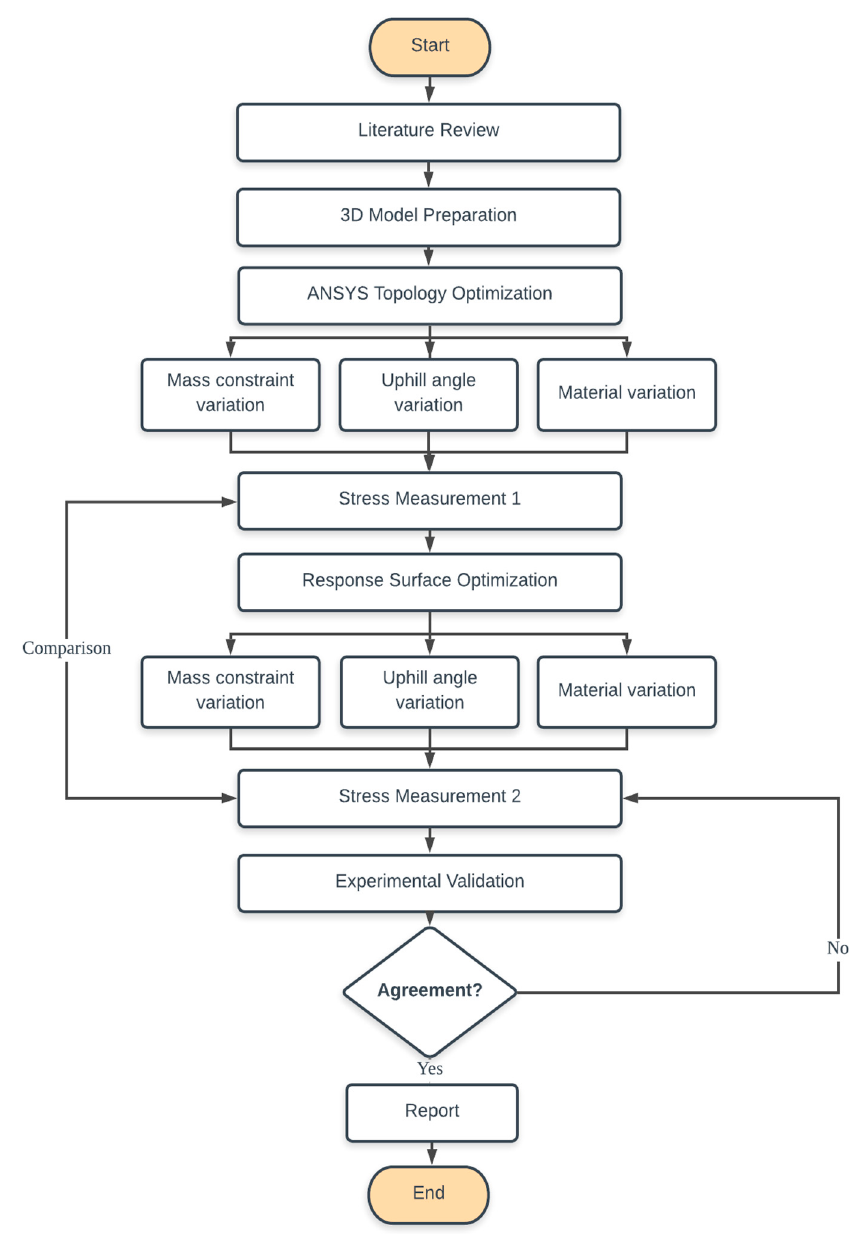
Figure 1. Flowchart of the research.